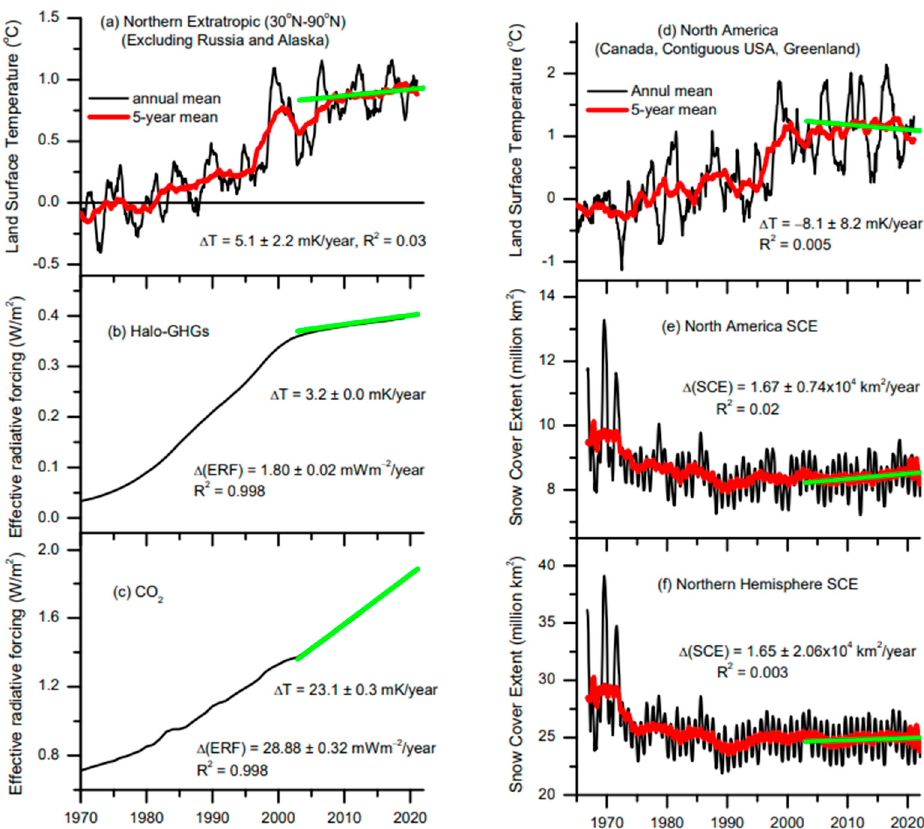
Figure 6. ( a ): Time-series measured land surface air temperature at Northern Hemisphere (NH) extratropic (30 ◦ N–90 ◦ N) excluding Russia and Alaska. ( b , c ): Time-series calculated effective radiative forcings (ERFs) of atmospheric CO 2 and halogenated greenhouse gases (halo-GHGs), given in climate models [5,8]. ( d ): Time-series measured surface temperatures in North America (Canada, contiguous USA and Greenland). ( e , f ): Time-series snow cover extent (SCE) in North America and NH during 1968–2021. For each dataset in ( a – f ), a linear fit to the observed data after 2005 is given (the green line), with the slope (changed amount per year) and the R 2 (COD) value